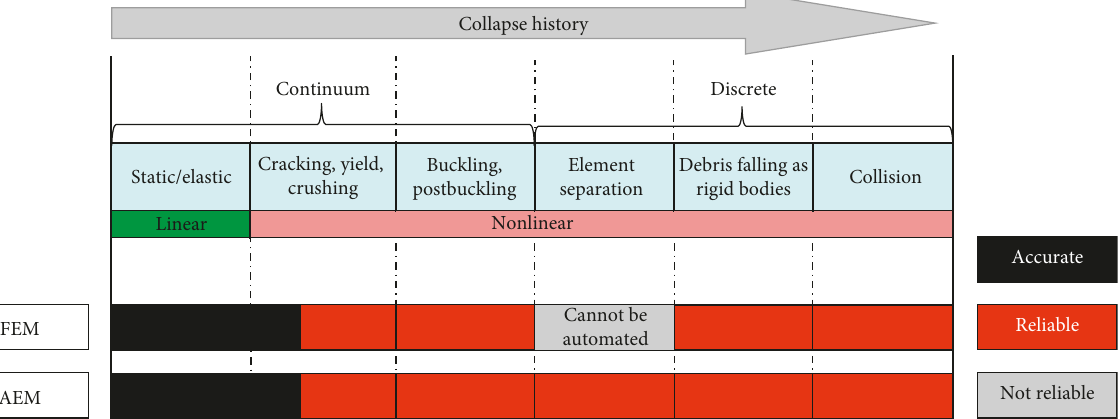
Figure 3: Comparison of analysis range between FEM and